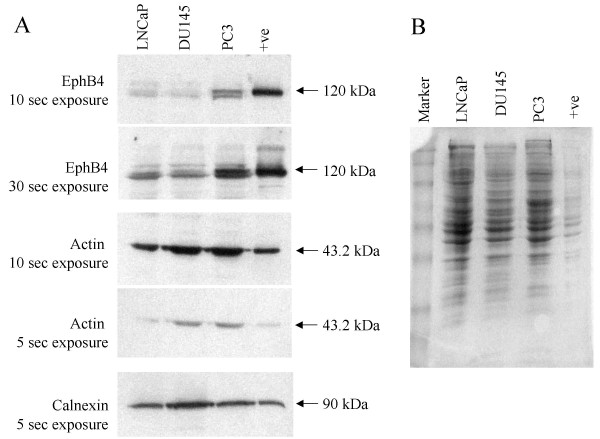
Western analysis of EphB4 in prostate cancer cell lines. Western analysis of 20 μg EphB4 protein in prostate cancer cell lines LNCaP (L), DU145 (D) and PC3 (P). (A) The immunoblot was incubated sequentially with antibodies specific to EphB4, α-actin and calnexin and exposed to autoradiographic film for the indicated times. MCF10A engineered to express EphB4 (5 μg protein lysate) was used as a positive control. The arrow indicates the expected size of each protein – 120 kDa for EphB4, 43.2 kDa for α-actin and 90 kDa for calnexin. The size of the marker proteins is shown on the left in kDa. (B) Coomassie stained duplicate gel for loading comparison.